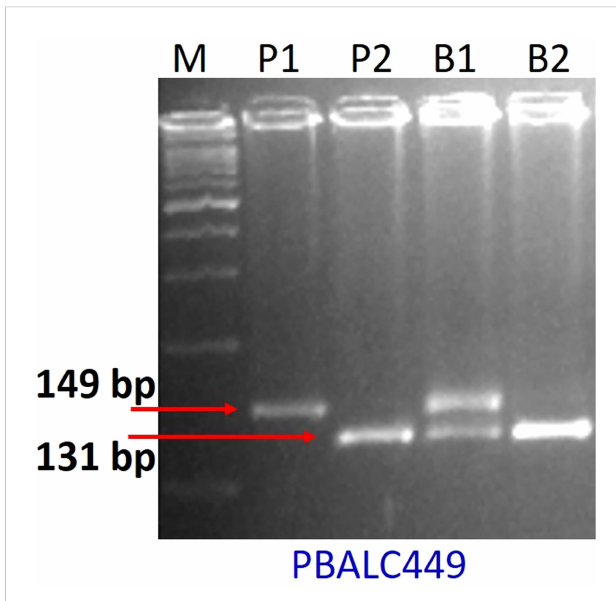
FIGURE 4 Gel picture showing BSA for seed size with PBALC449 marker. Where, P1: L4602, P2: L830, B1: large seeded bulk, B2: small-seeded bulk, M: DNA